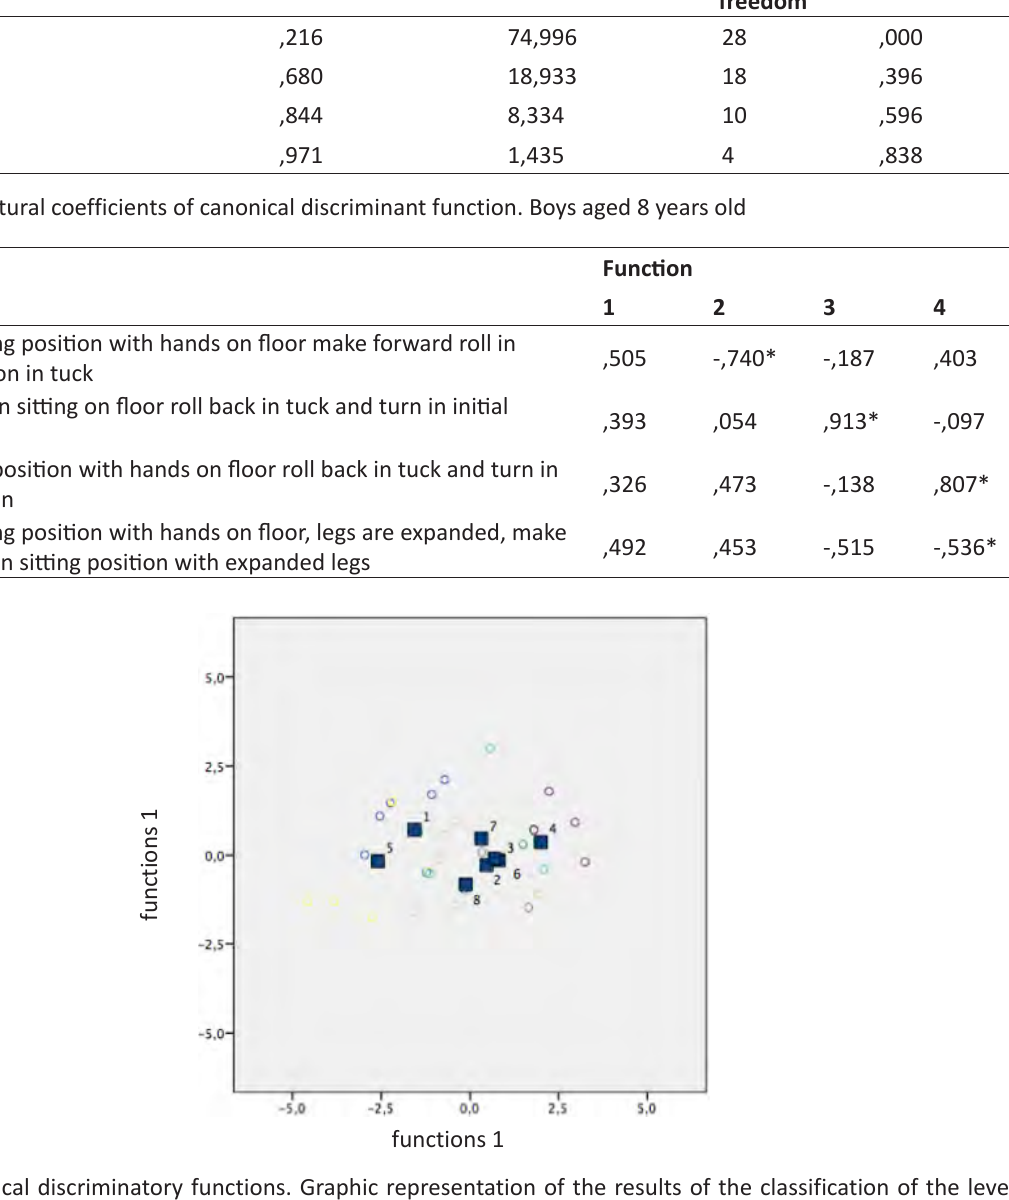
Table 3. Canonical discriminant function. Wilks’ Lambda. Boys aged 8 years old Control of functions